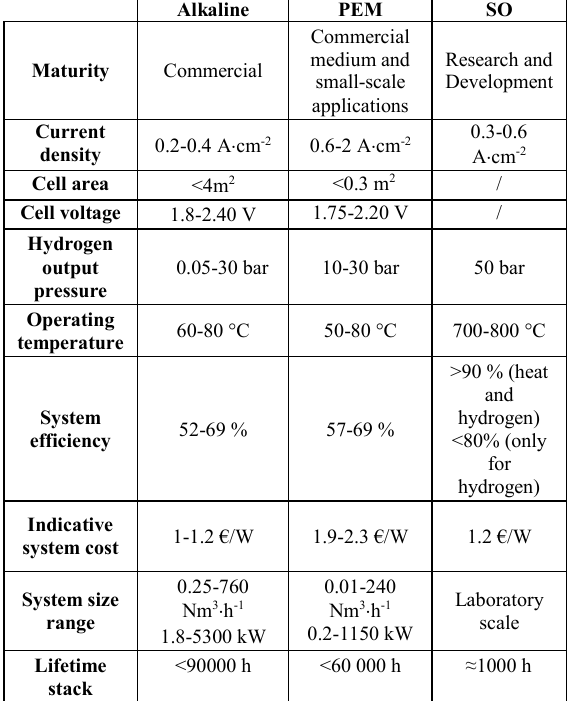
TABLE I M AIN FEATURES OF EACH ELECTROLYZER TECHNOLOGY Alkaline PEM